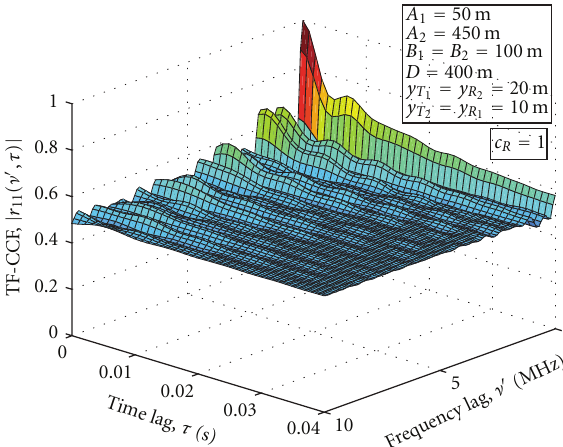
Figure 6: Absolute value of the TF-CCF | r 11 ( ν (cid:4) , τ ) | of the reference model for a LOS propagation scenario ( c R =